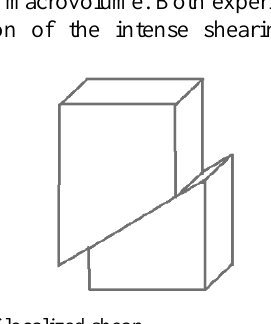
Fig. 1. Schematic representation of localized